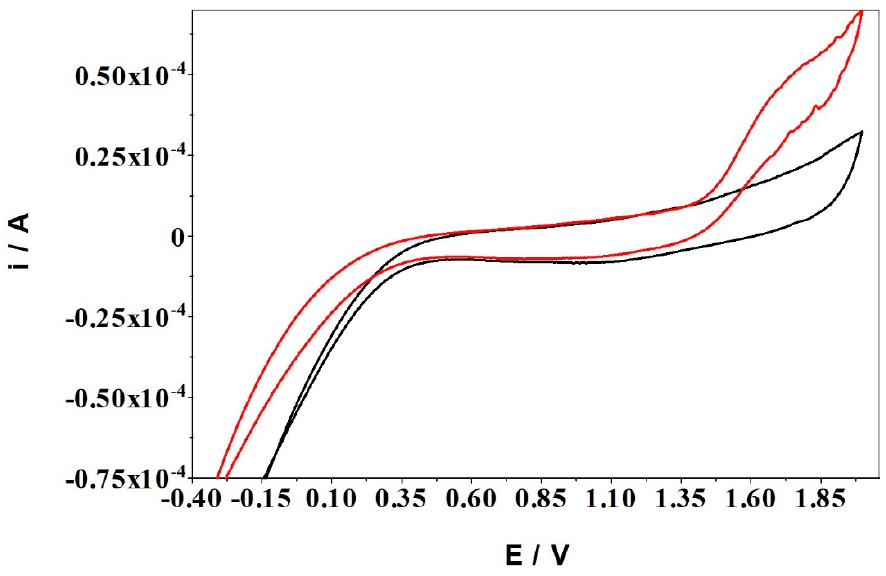
Figure 1. Cyclic voltammetry of 2 mL chloroform-TBAP + 1 mL acetic anhydride + 40 µ L H 2 SO 4 without cholesterol (black line) and with 0.64 mM cholesterol (red line), using GC and 0.1 V/s scan rate.